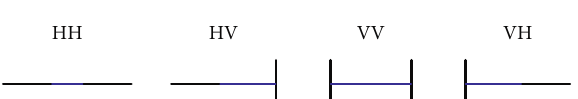
Figure 6: The schematic of polarimetric radar about the four transmitter-receiver pairs.